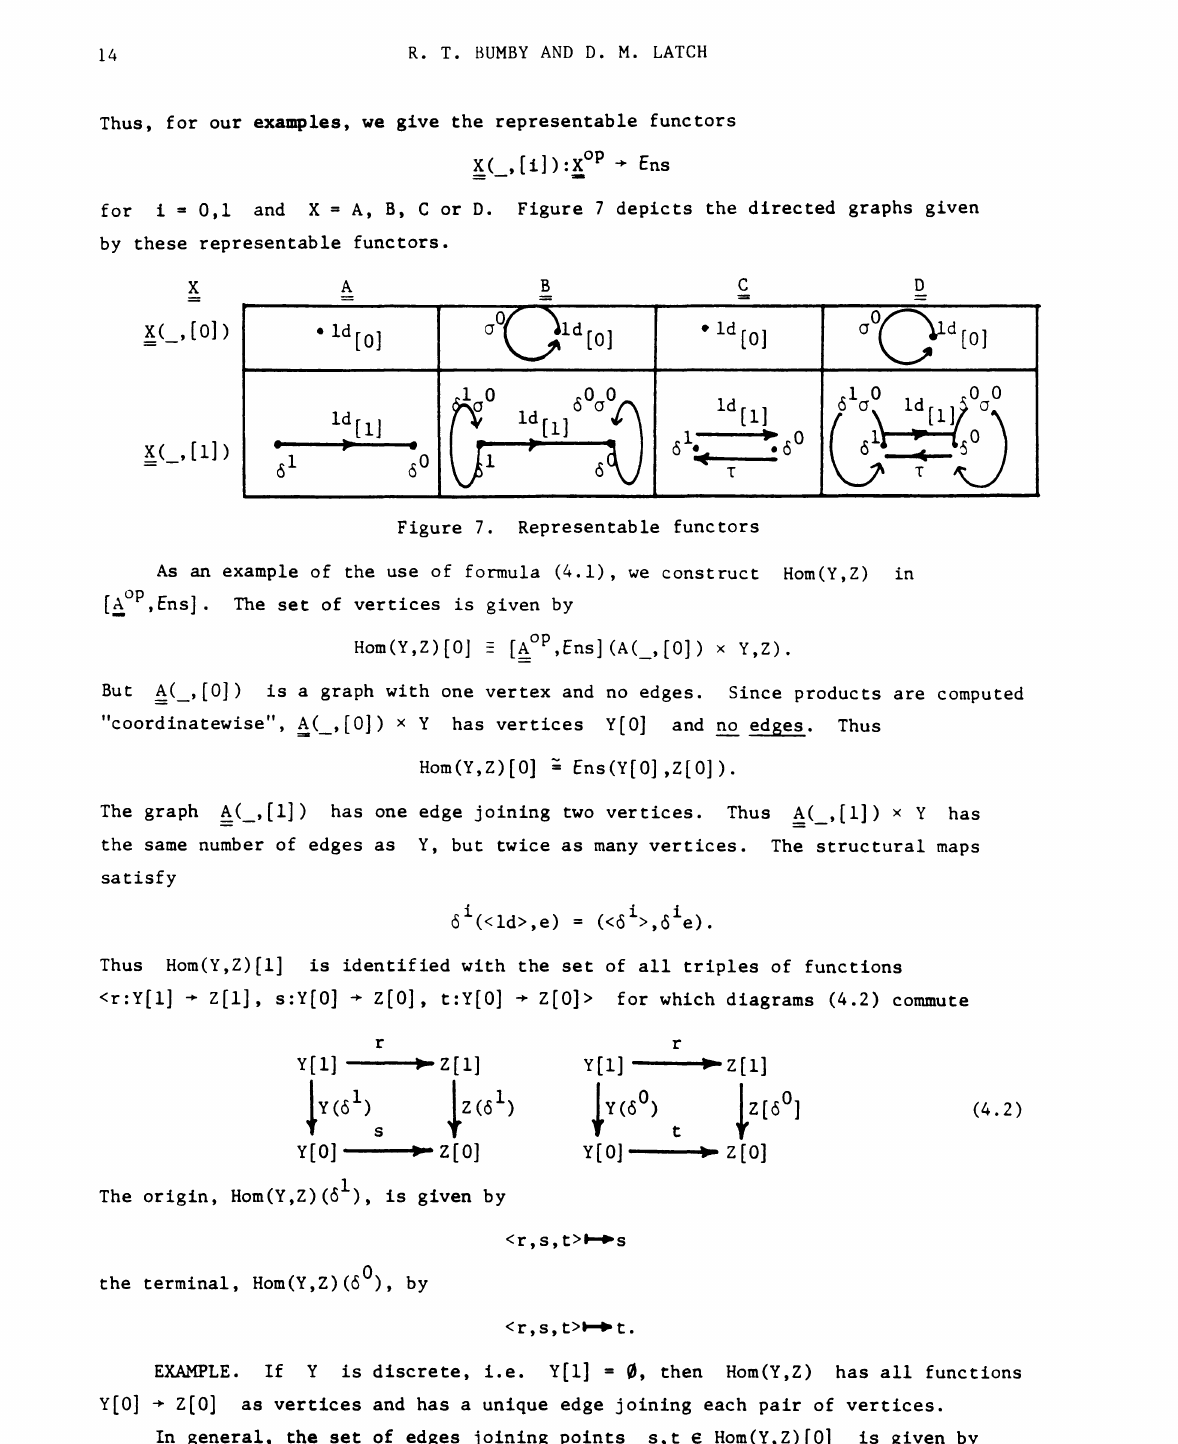
Figure 7. Representable